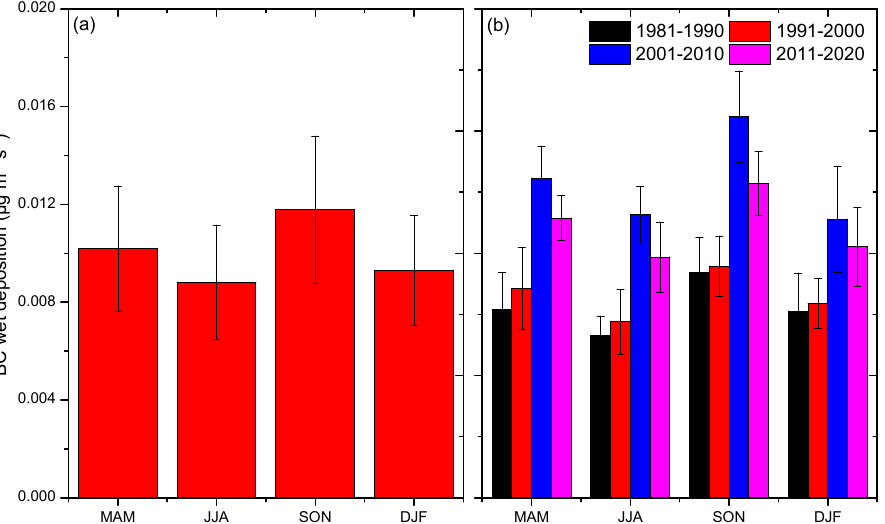
Figure 5. Seasonal variations of area-averaged black carbon wet deposition flux over the Sichuan Basin from 1981 to 2020 (MAM, JJA, SON and DJF represent spring, summer, autumn, and winter, respectively) ( a ) and in four periods ( b ) during 1981–1990, 1991–2000, 2001–2010, and 2011–2020.